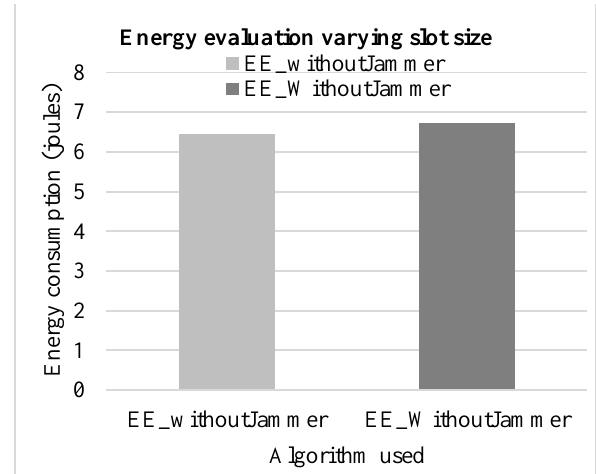
Figure 5 Energy efficiency performance considering varied slot size.